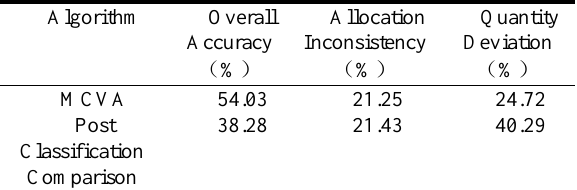
Table 9 Change detection accuracy of MCVA method and post classification comparison method